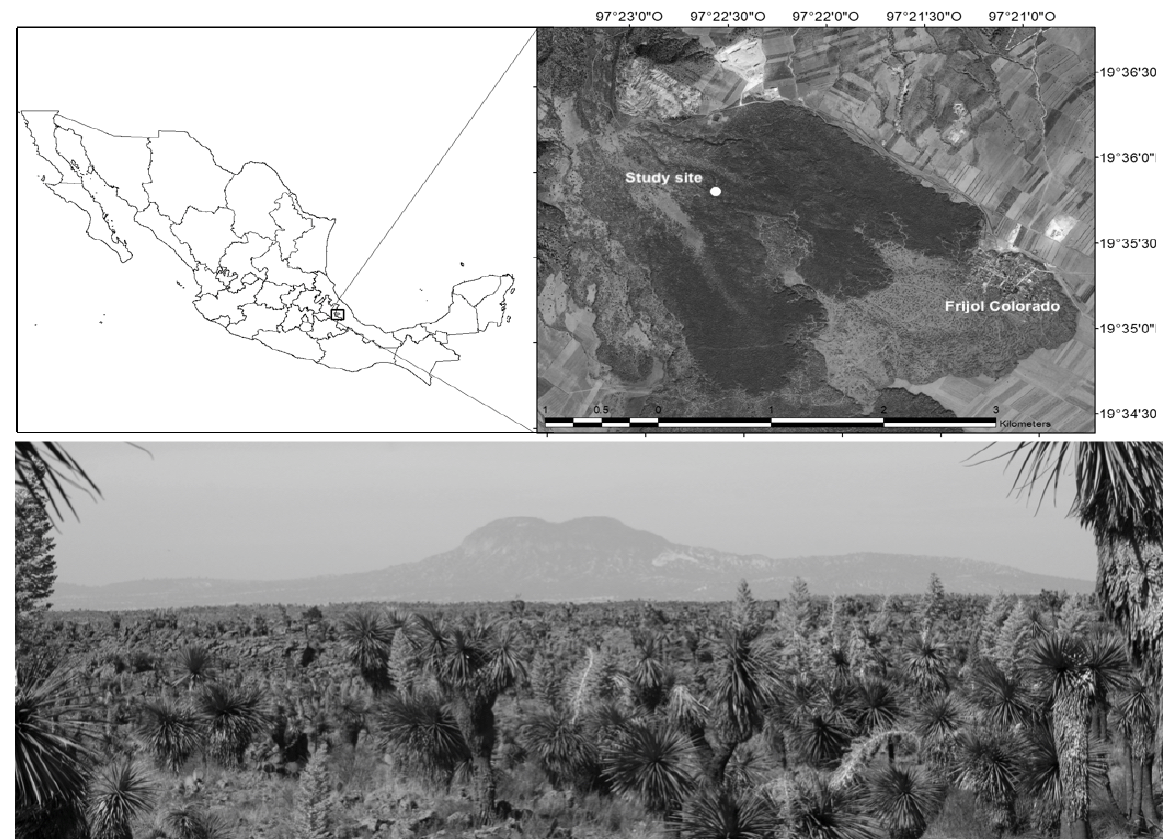
Figure 1. Study area in arid zone showing the lava flow environment near the town of Frijol Colorado (l9°36 ′ 28.42 ″ N, 97°22 ′ 55.74 ″ W). A panoramic view of “malpaís” is also shown with the predominant plant species Nolina parviflora and Opuntia huajuapensis , a habitat where the honeybee Apis mellifera and the native bee Lithurgus littoralis develop.